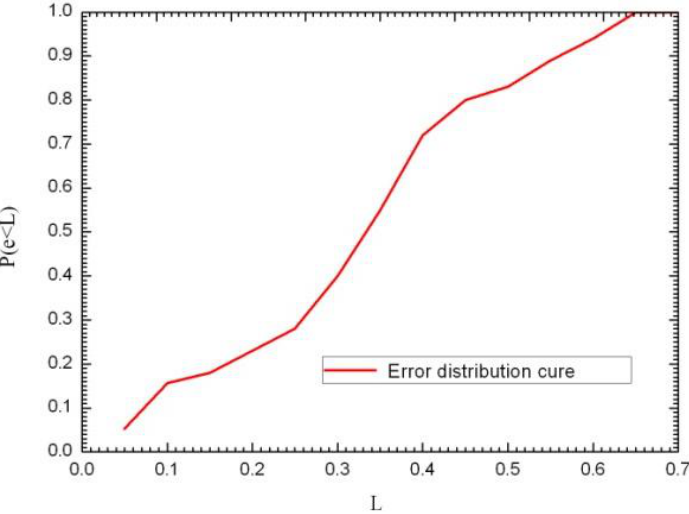
Figure 9. Localization-error probability distribution